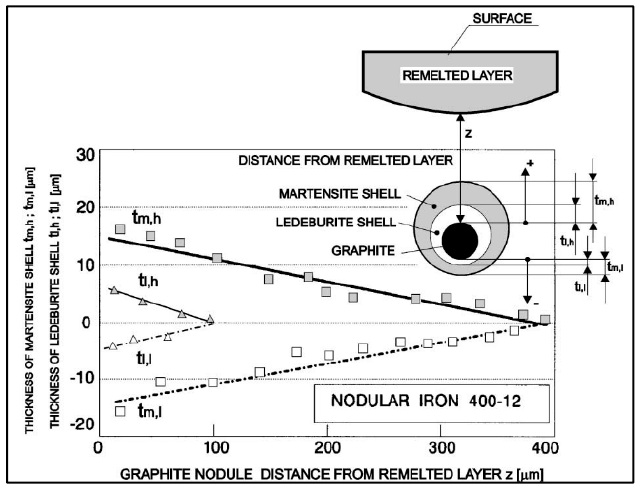
Figure 14. Comparison of the experimental and predicted thickness of martensite and ledeburite shells around graphite nodules (Reprinted with permission from ref. [64]. 2002 Elsevier).